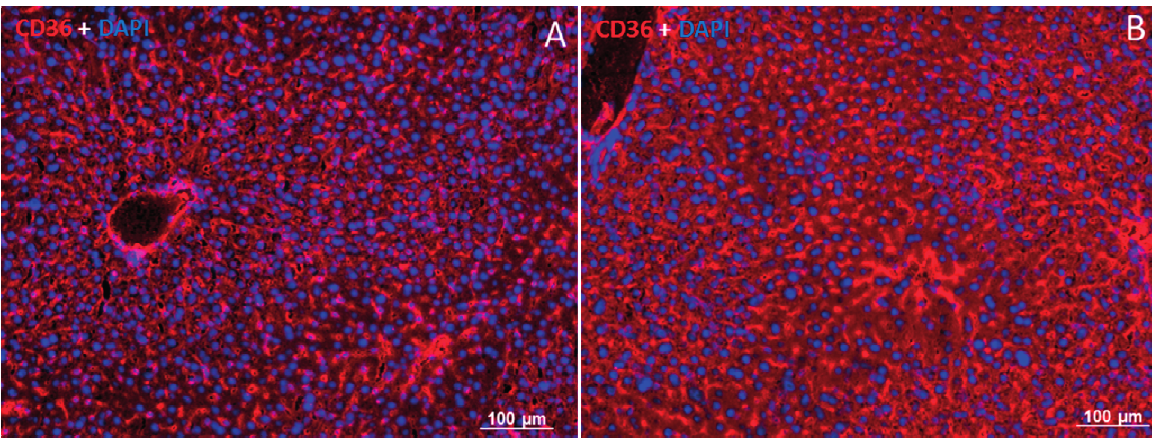
Figure 6. Immunofluorescence detection of FAT/CD36 in liver cryosections of sham-irradiated control and irradiated mice. Sham-irradiated controls ( A ); 6 h post-RT ( B ). Staining with the monoclonal anti-FAT/CD36 antibody showed an increased protein expression of FAT/CD36 (red) after irradiation. Counter staining of the nuclei was done with 4',6-diamidino-2-phenylindole (DAPI). Results show the representative picture